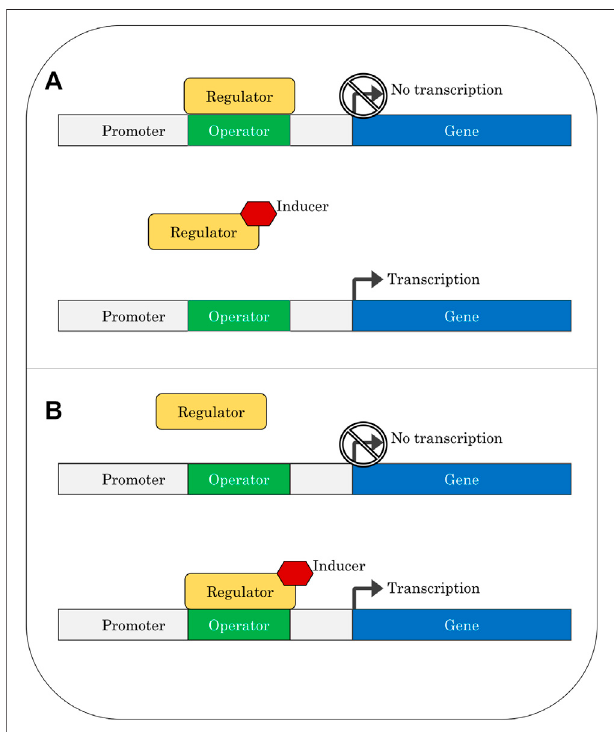
FIGURE 1 | Gene regulation via repressor protein (A) or activator protein (B)